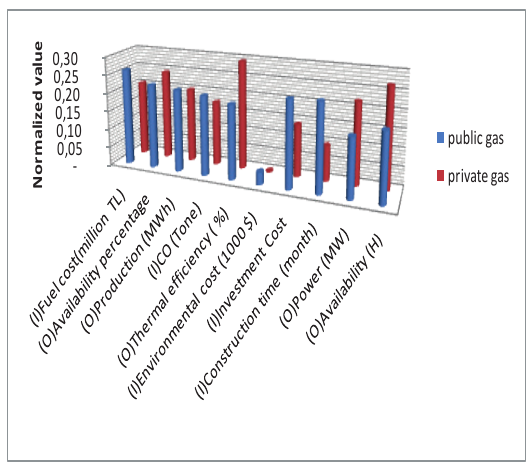
Fig. 3. Comparison of natural gas - based public and private power